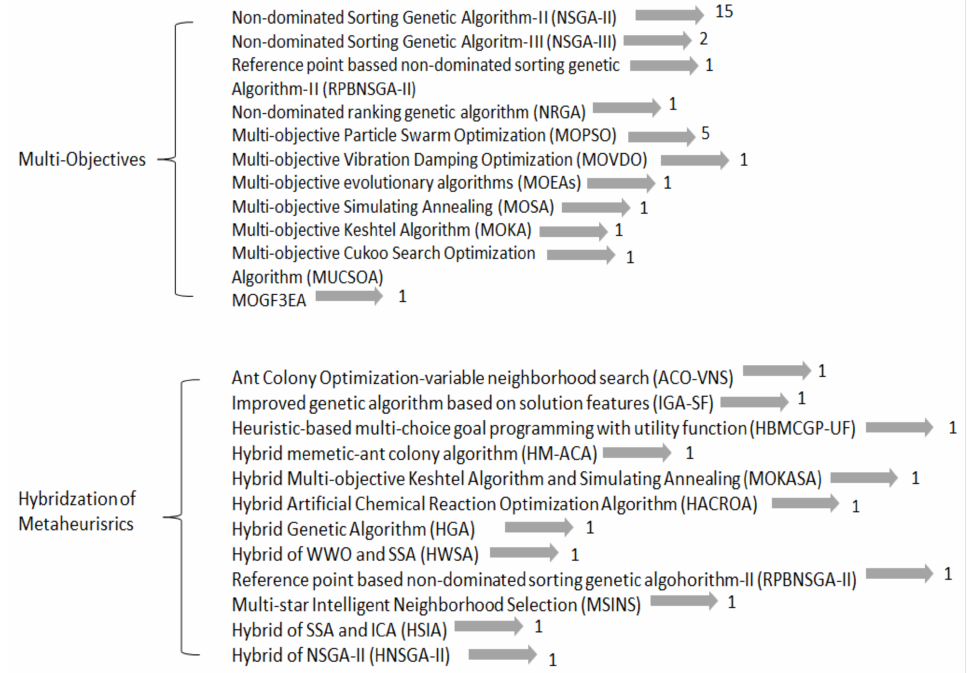
Figure 9. Multi-objective and Hybridization of